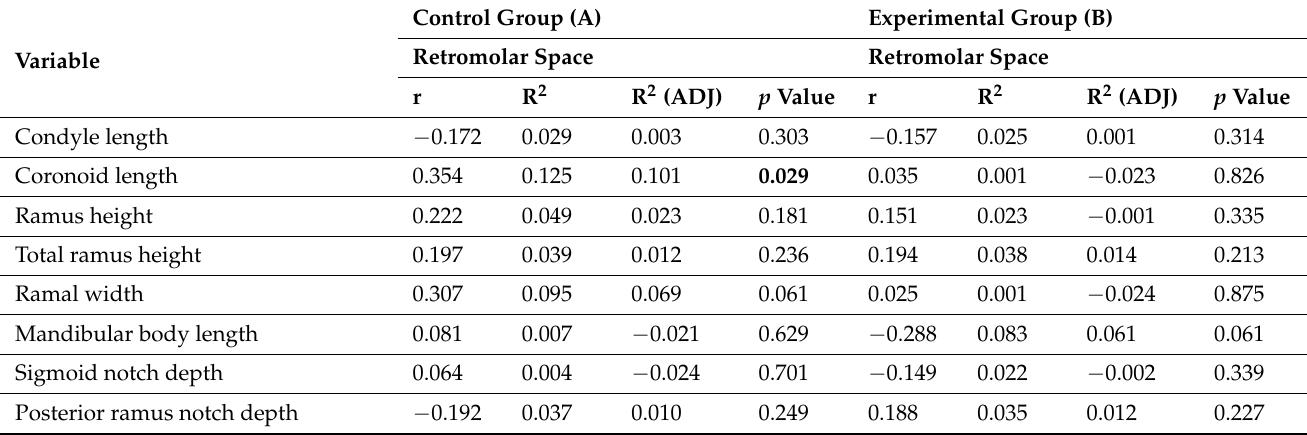
Table 2. Pearson’s correlation and linear regression tests